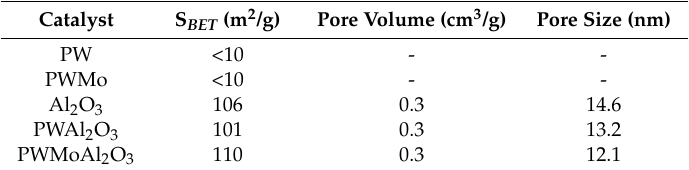
Table 1. Textural properties of bulk and supported catalysts.